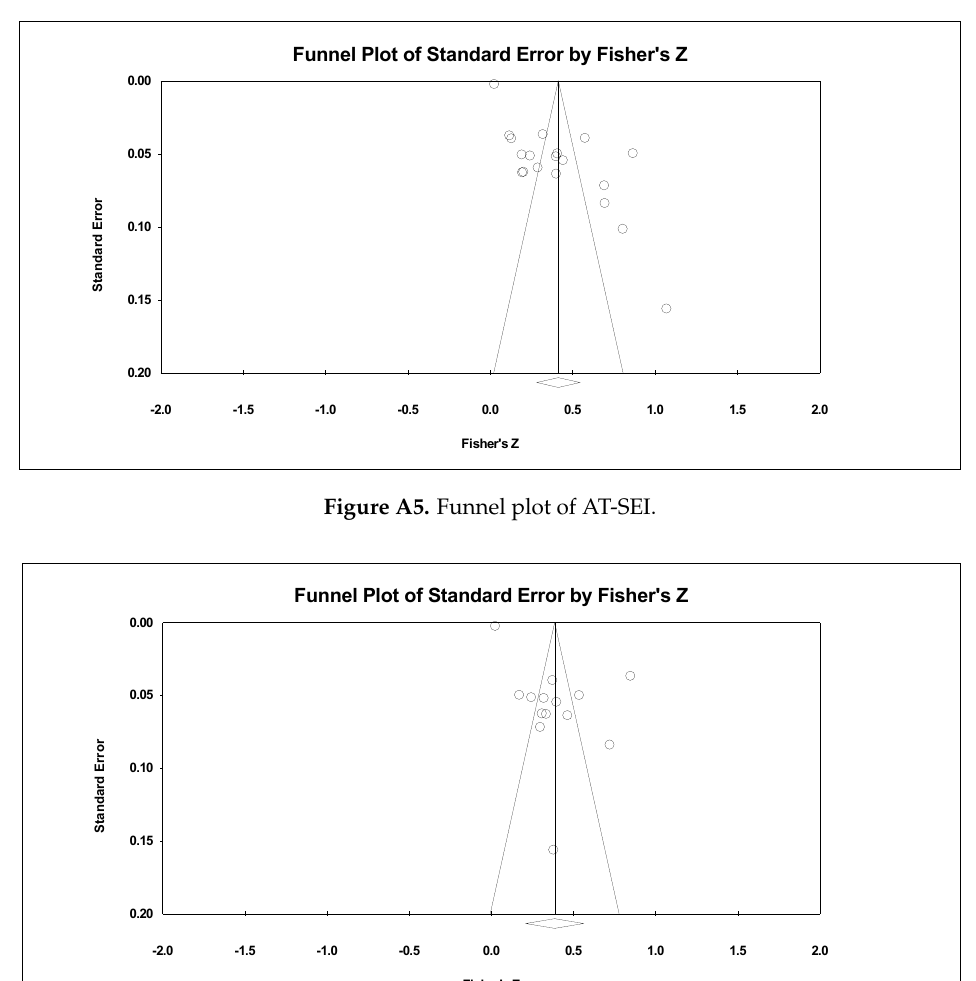
Figure A6. Funnel plot of SN - SEI.